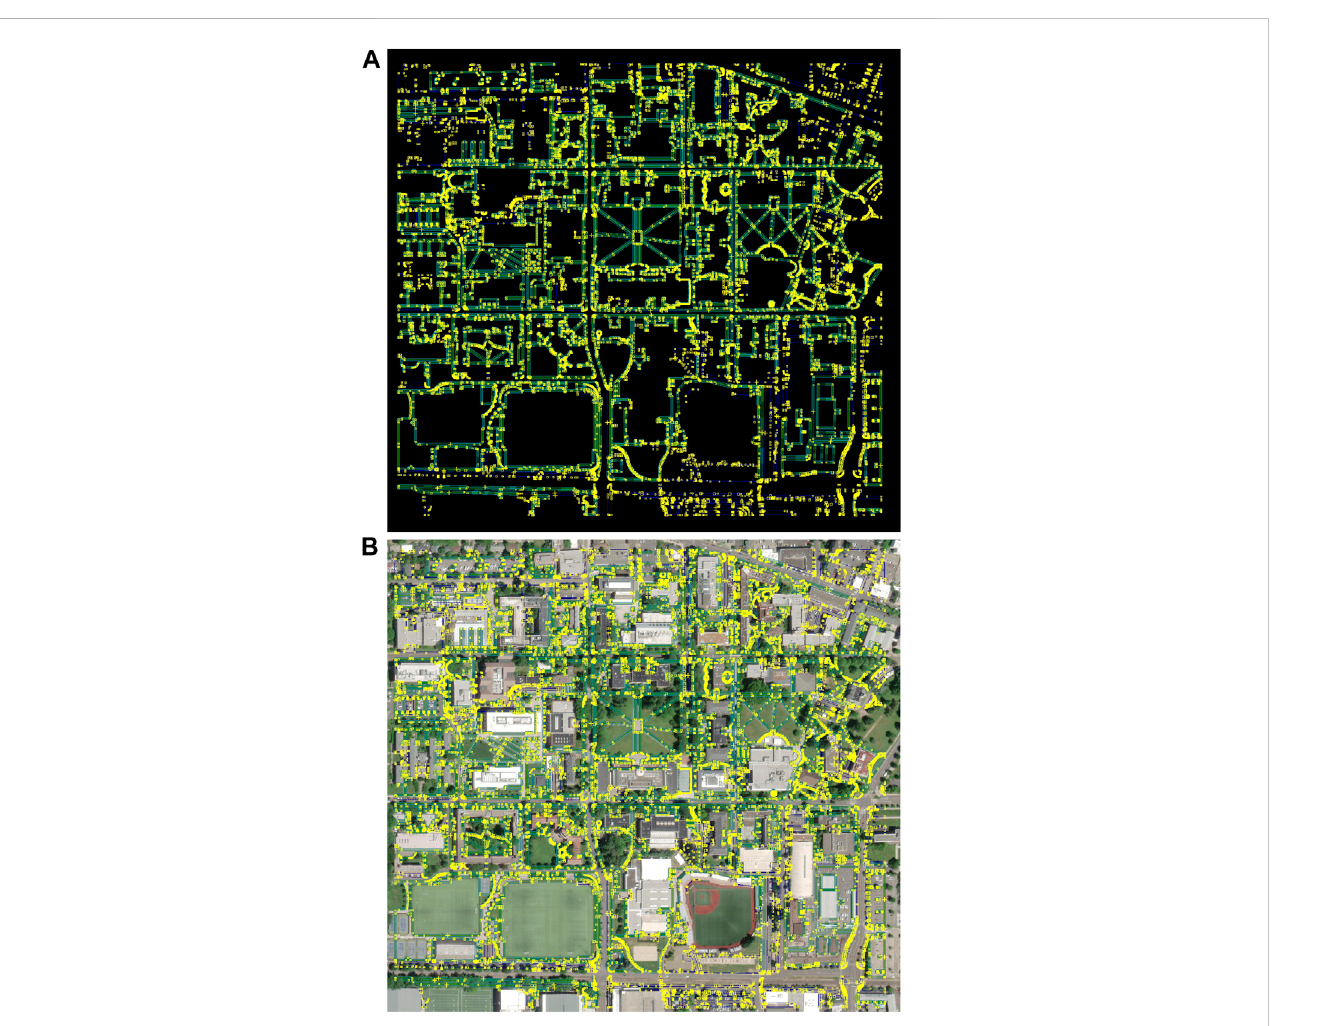
FIGURE 8 TherawdataoftheDigitalTwinafterthedatacombinationusingSafeFME. (A) DigitalTwin-Data, (B) DigitalTwin-DataoverlaidwithEsrisatelliteimagery. (© Esri, Maxar, Earthstar Geographics, GIS User Community). The base maps was created using ArcGIS ® software by Esri. ArcGIS ® and ArcMap ™ are the intellectual property of Esri and are used herein under license. Copyright © Esri. All rights reserved. For more information about Esri ® software, please visit